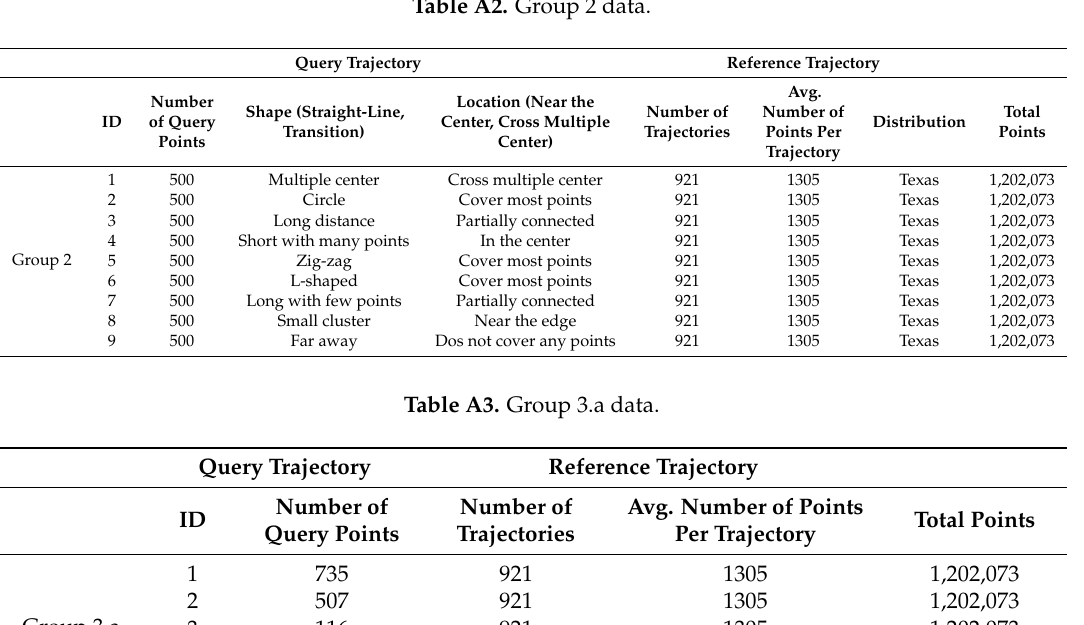
Table A2. Group 2 data.